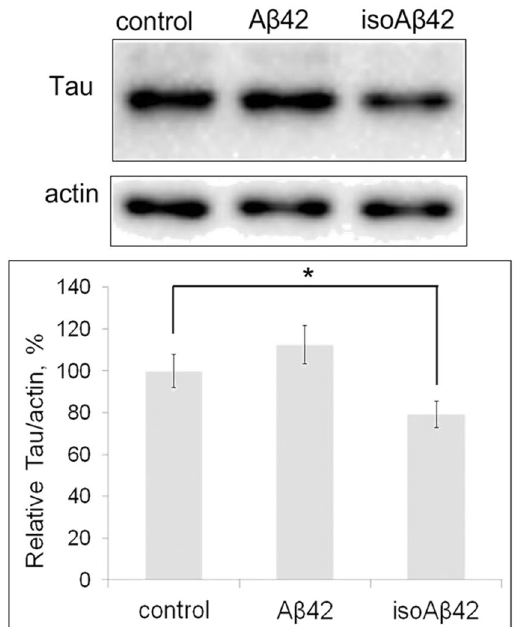
Figure 7. Effect of A β 42 and isoA β 42 (10 μ M, 6 h) treatment on the total tau protein level. After incubation with the amyloid peptides, the SH-SY5Y cells were lysed, the proteins in the cell lysate were separated by SDS-PAGE, and total tau was detected by Western blot using antibodies against total tau. The total tau level is expressed as a percentage of the tau level in the control group, which was not treated with A β s. The bars represent the changes in the total tau level. Each value is the mean ± SD of at least three independent experiments; * p < 0.02.